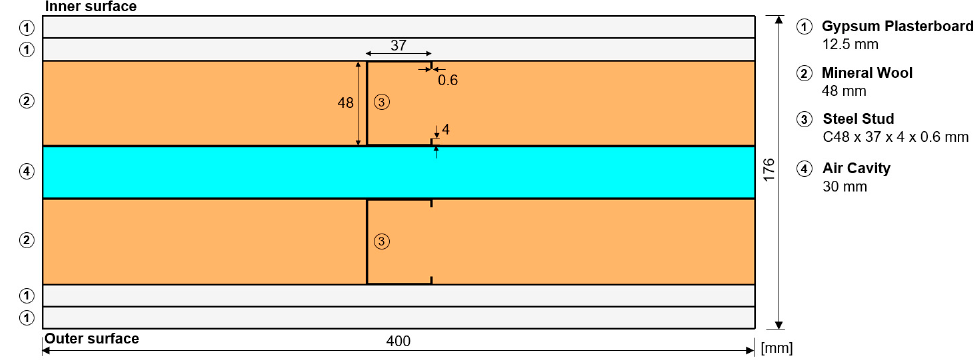
Figure 1. Geometry and materials of the reference double-pane LSF wall: horizontal cross-section.